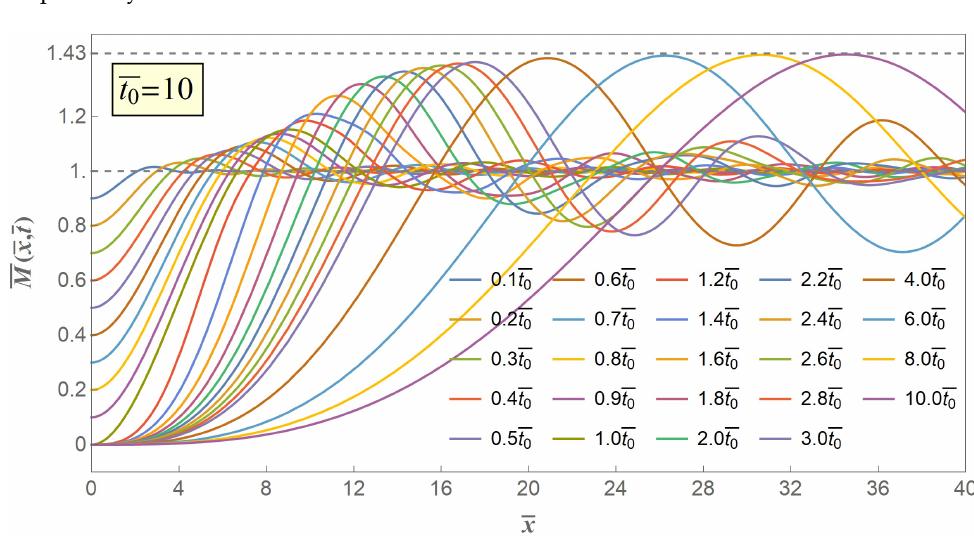
Figure 5. Schematic of excited bending moment versus distance when t 0 = 10.